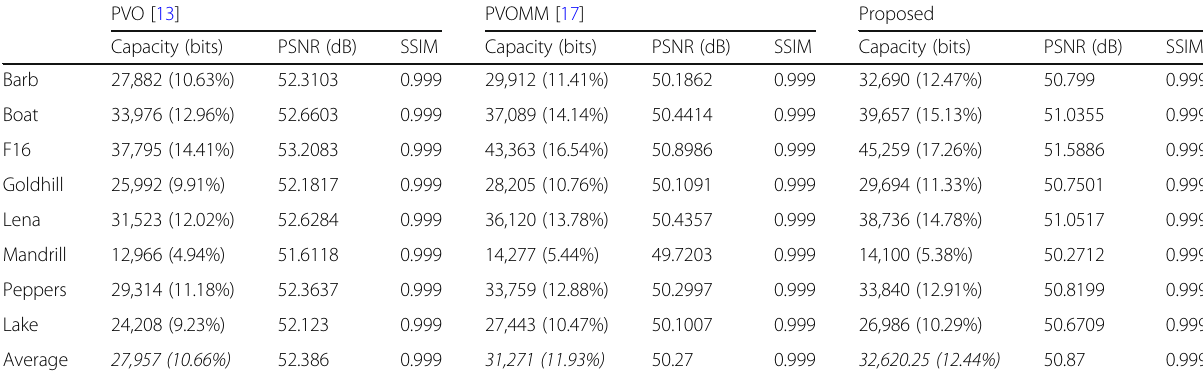
Table 5 Comparison of steganographic capacity, PSNR, and SSIM of the proposed method, PVO, and PVOMM